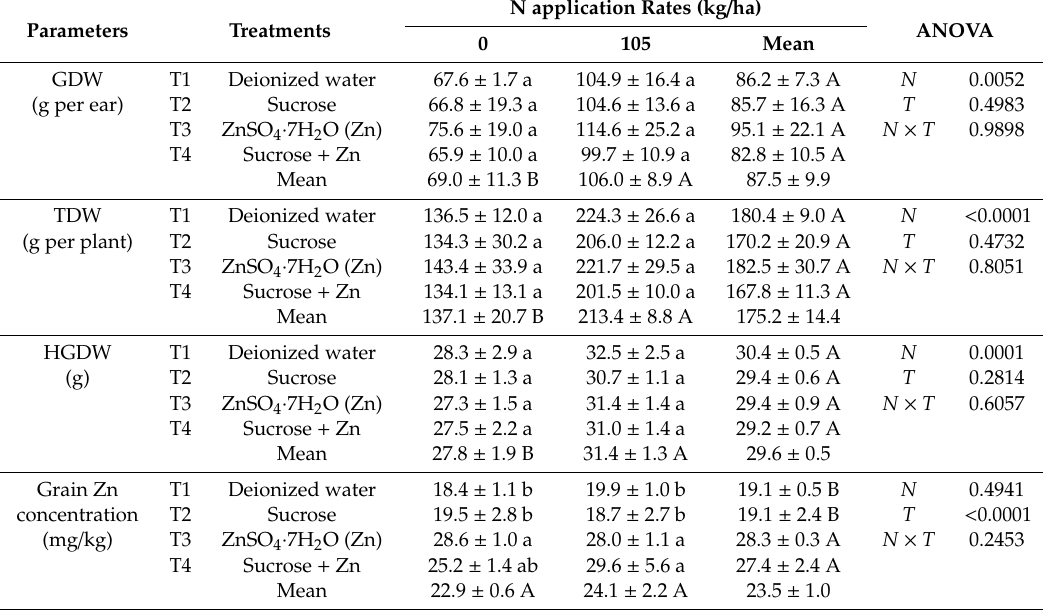
Table 3. E ff ects of di ff erent foliar treatments and N application rates on maize grain dry weights (GDW), total dry weights (TDW) including grain and straw, hundred grain dry weights (HGDW) and grain Zn concentrations and contents in the field experiment at